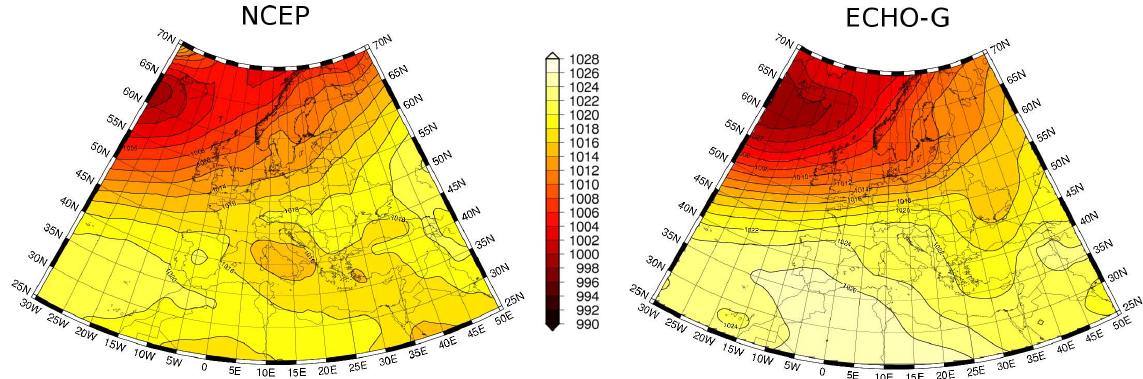
Fig. 5. MSLP in winter in the reference period in the NCEP reanalysis (Kalnay et al., 1996) (left panel) and simulated by ECHO-G (right panels). The units are